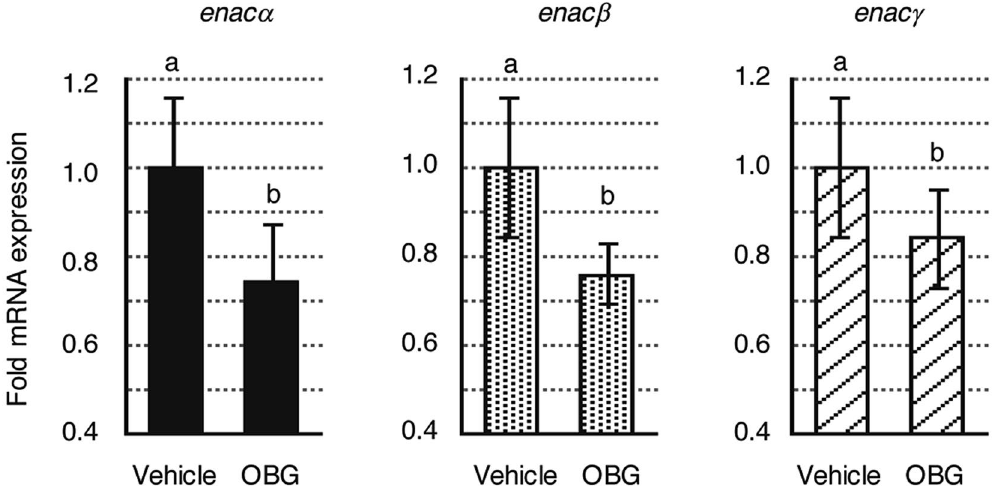
Figure 6. OBG represses enac mRNA expression in the mouse kidney. mRNA extracts were prepared from the kidney of mice treated with 1 mg/kg OBG, and the mRNA expression levels of enac in extracts were analysed as described in Fig. 4A.